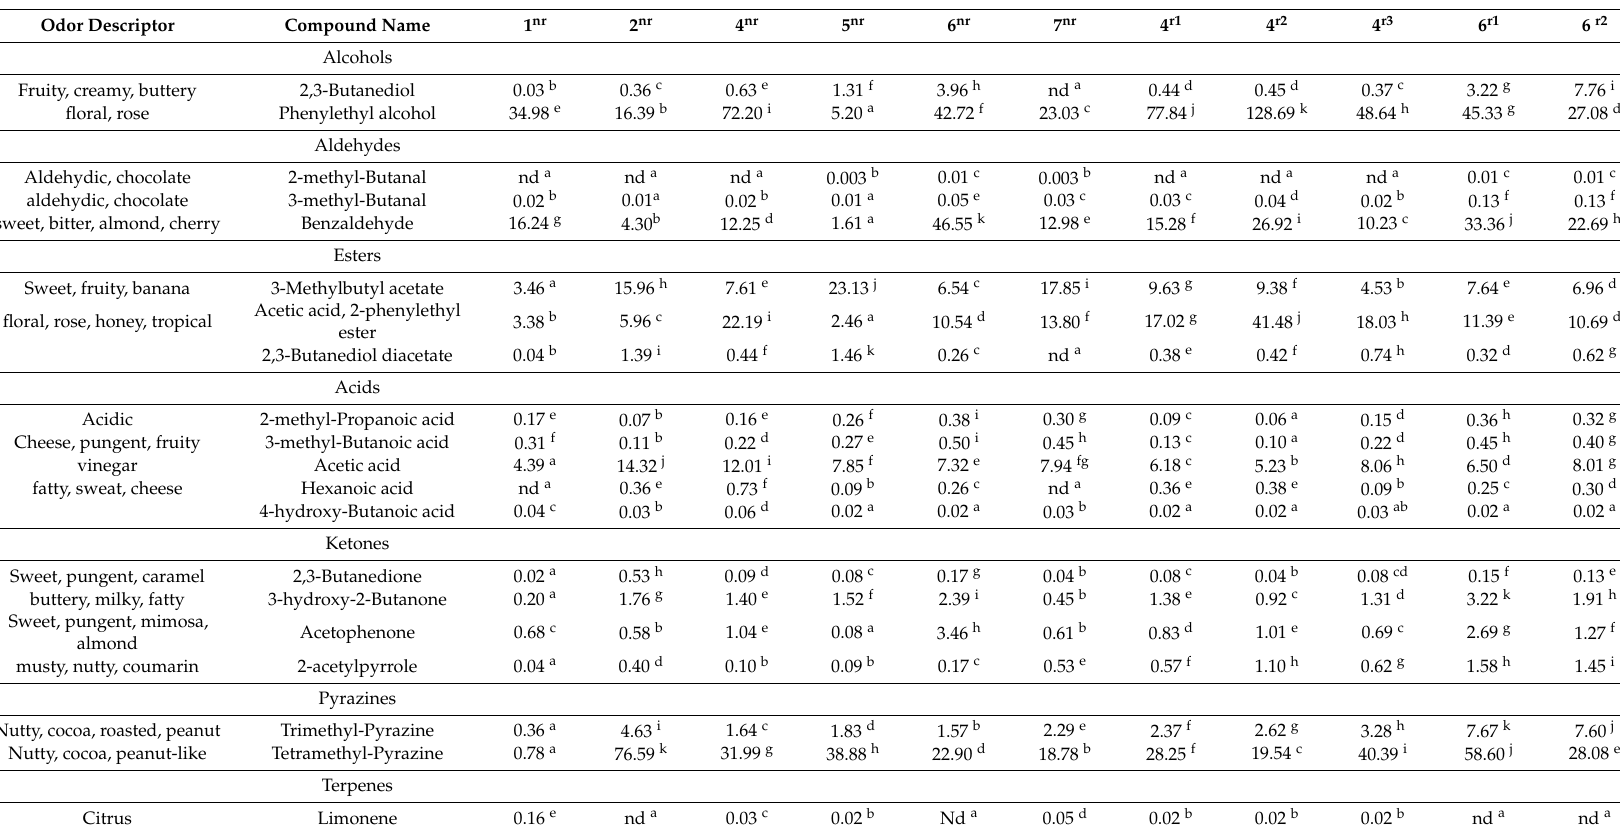
Table 3. Key aroma volatiles in raw samples and in roasted samples together with their odor descriptors, normalized peak area from Q (quantitation)-ion, and Internal Standard (IS). Data obtained from triplicate analysis with SD <